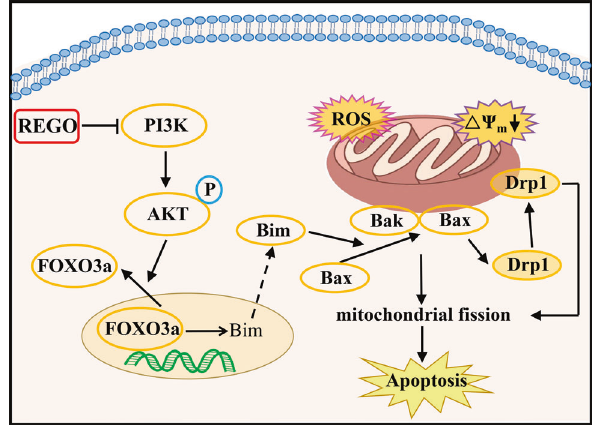
Fig. 6 A schematic diagram of the molecular mechanism by which REGO induces apoptosis in cancer cells. REGO downregulates PI3K expression to dephosphorylate AKT that suppresses FOXO3a translocation from nucleus to cytosol, which upregulates Bim expression. Bim triggers Bax translocation to mitochondria, and mitochondrial Bax recruits Drp1 to mediate mitochondrial fi ssion and Bax/Bak oliogomerization as well as subsequent MOMP.